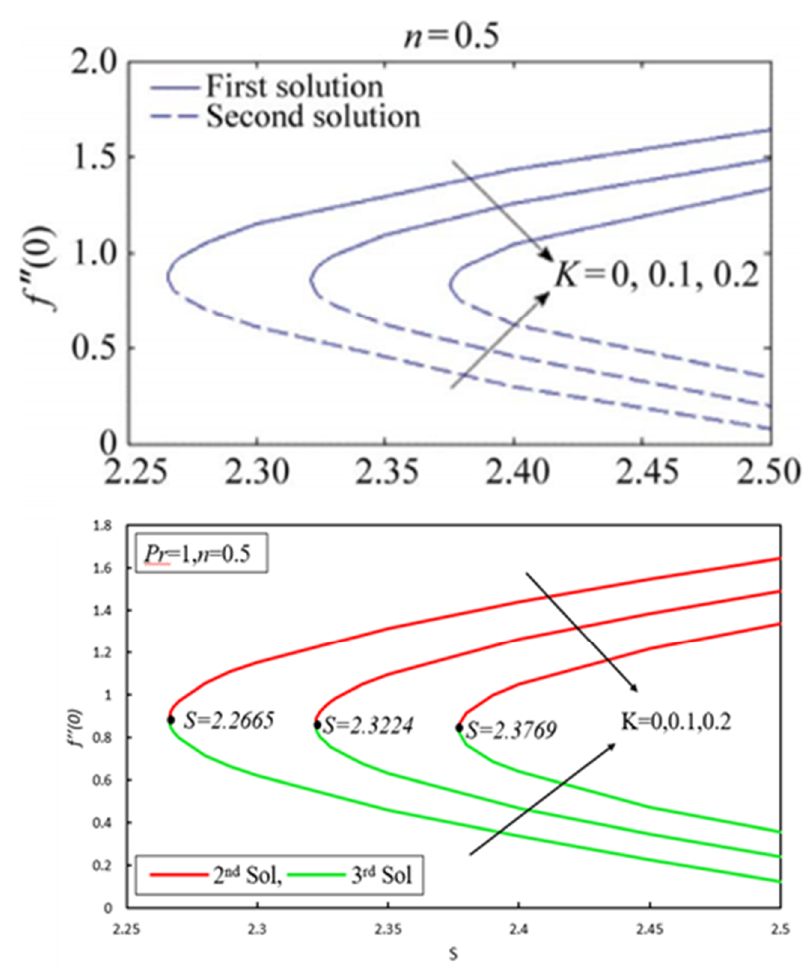
Figure 3. Comparison between upper graph: existing results obtained by Aurangzaib et al., [29] and lower graph: present results.